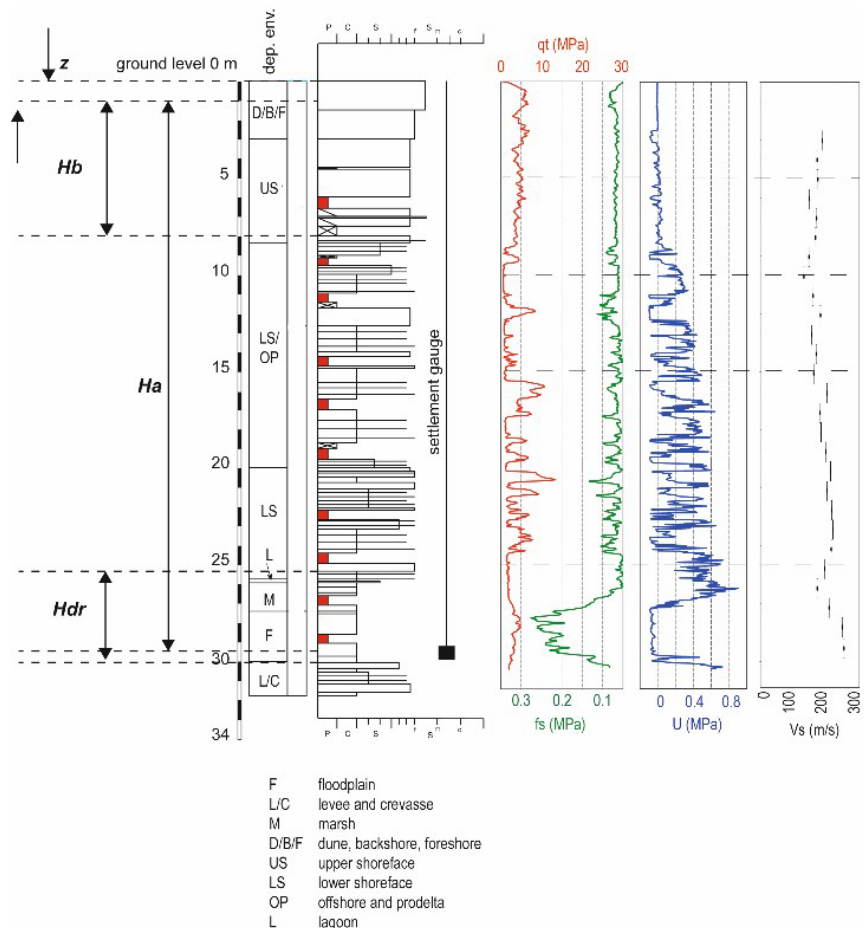
Figure 2. Stratigraphic core log of the borehole where the settlement gauge is installed and Standard Cone Penetration Test (SCPT) carried out next to the log. Depositional environments (dep. env.): floodplain (F), levee and crevasse (L/C), marsh (M), dune backshore and fore- shore (D/B/F), upper shoreface (US), lower shoreface (LS), offshore and prodelta (OP) and lagoon (L). Lithology: P = peat, C = clay, S = silt, S = sand f = fine, m = medium, c = coarse. CPT parameters: qt = cone resistance, fs = lateral friction, U = pore pressure, Vs = shear wave velocity, z = depth, H a = depth of the settlement gauge, H b = depth of the bottom of the first sand package, and H dr = equivalent thickness of clay level (from Antonellini et al.,